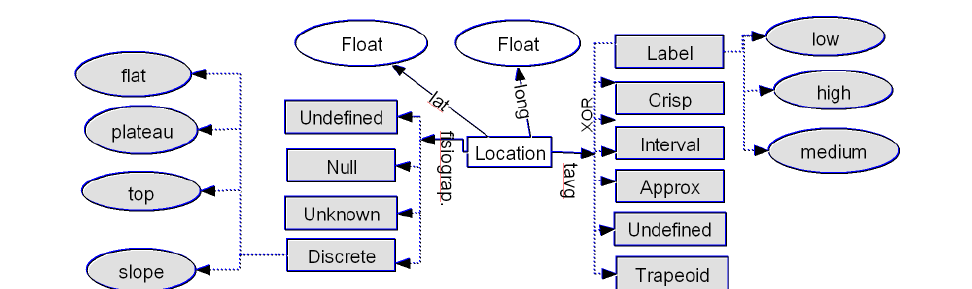
Fig. 5. Partial example of land characteristics database domain ontology.